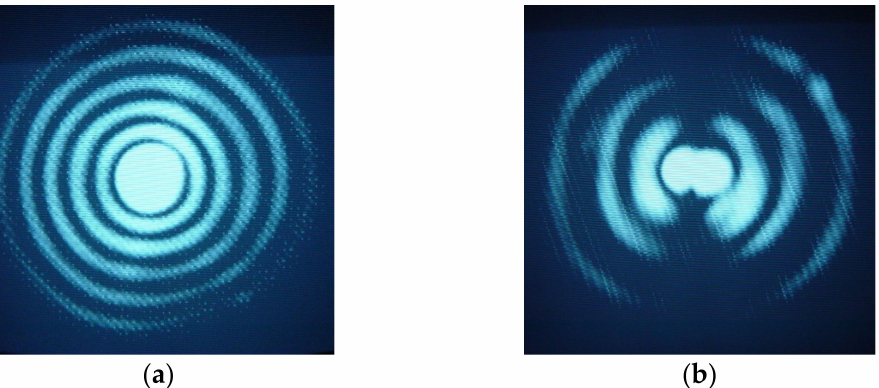
Figure 13. Intensity distribution in the near field for the ( a ) LP 07 cladding mode of a 415 µ m-LPFG written in the B/Ge fiber and ( b ) LP 14 cladding mode of a 540 µ m-LPFG written in the SMF28 fiber. Reprinted with permission from ref. [129]. © 2006 The Optical